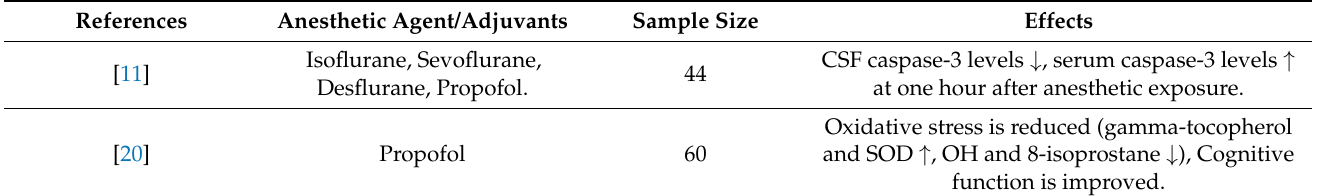
Table 2. Anesthetics and adjuvants in early brain injury (EBI) after SAH in